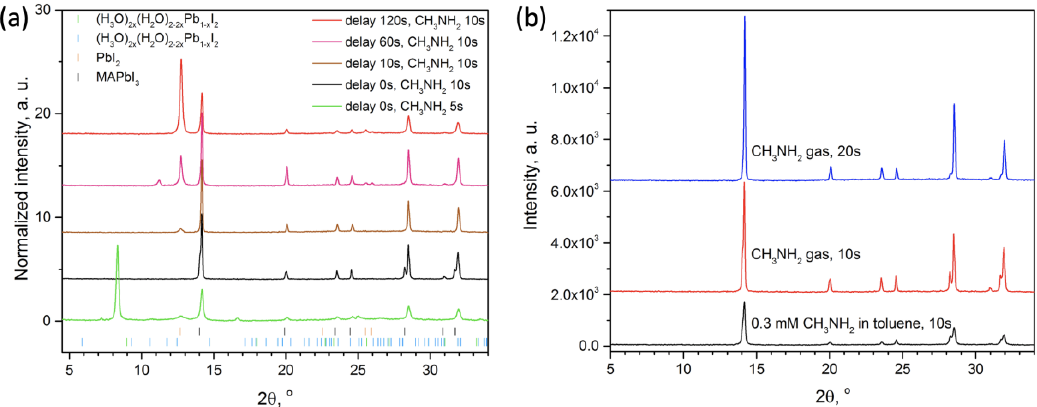
Figure 5. Diffraction patterns ( a ) of the precursor films after different methylamine vapors exposure time (5 and 10 s) and with various delay after deposition (0–120 s) and ( b ) single-phase perovskite films obtaining under conversion by methylamine gas (5 and 10 s of exposure) or diluted methylamine solution in toluene. Positions of the reflections of the known phases are indicated by colored sticks.